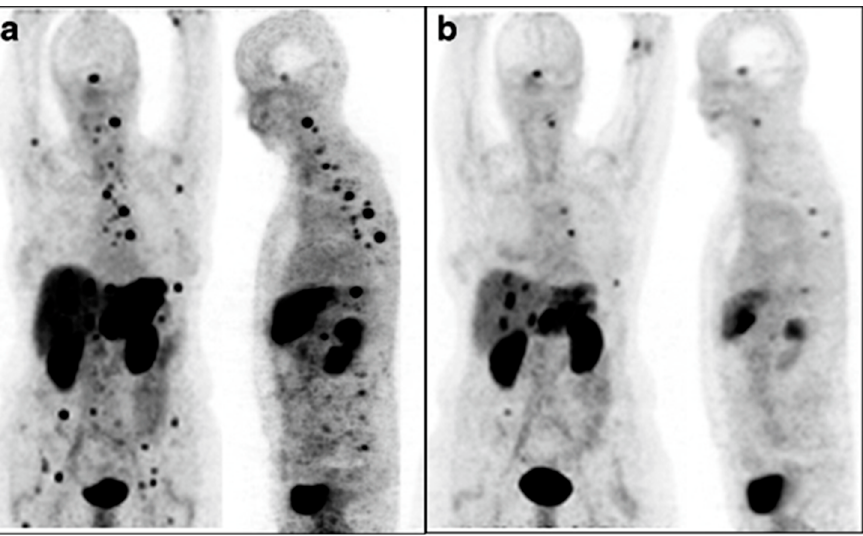
Figure 6. Intra-arterial Bi213-DOTATOC overcomes Y90-DOTATOC resistance. Ga-68-DOTATOC- PET imaging shows bulky liver disease and widespread lesions before treatment ( a ). Reduction in both primary liver and metastatic disease was seen on imaging six months after administration of Bi-213-DOTATOC into the common hepatic artery ( b ). This research was originally published in the European Journal for Nuclear Medicine and Molecular Imaging [55]. Accessed on 1 February 2023 https://creativecommons.org/licenses/by/4.0/legalcode.